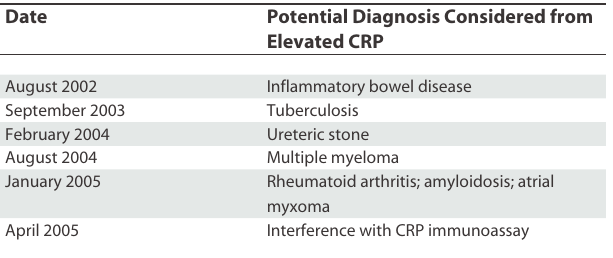
Table 1. Potential Differential Diagnoses Considered to Explain Elevated